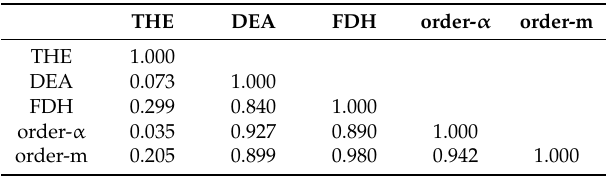
Table 3. Spearman rank correlation coefficients for